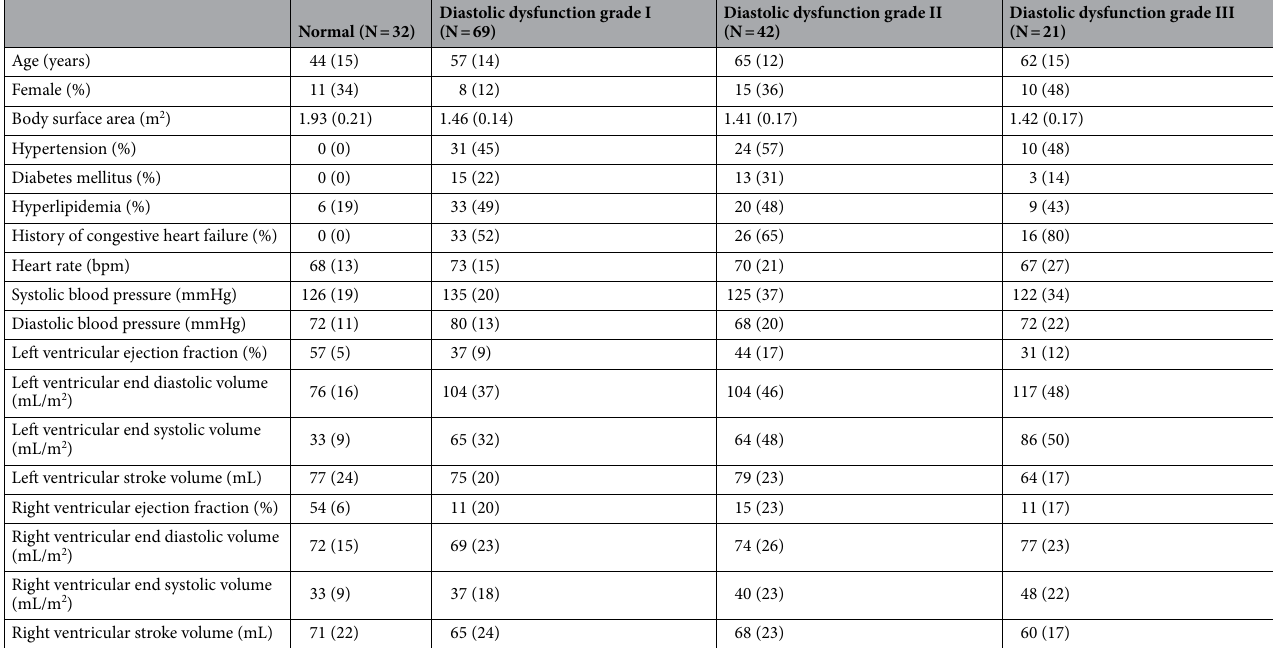
Table 1. Baseline characteristics* describing subjects with and without left ventricular diastolic dysfunction. *Described as mean (SD) or N